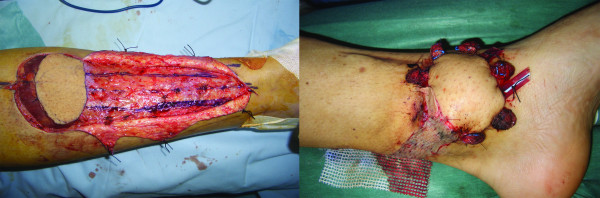
Pre-operative x-ray.